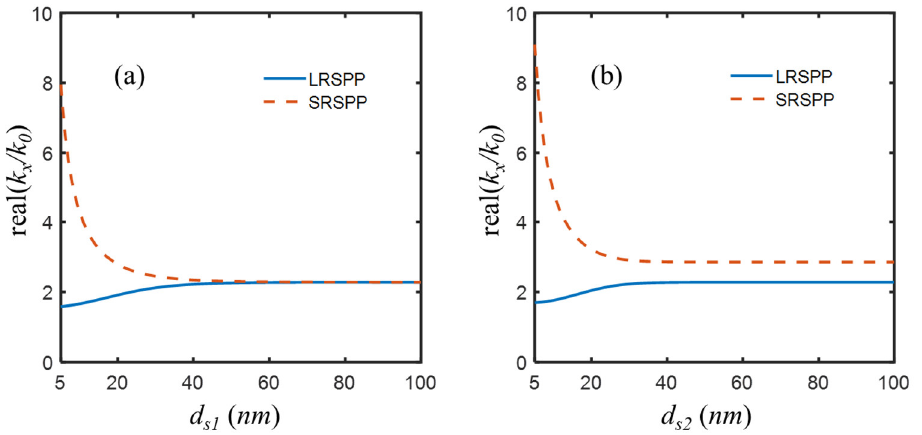
Figure 4. Real part of effective mode indices n ef f = k x / k 0 of LRSPP and SRSPP supported by totally independent ( a ) symmetric IMI with ε p = ε d = 2.4 and ( b ) asymmetric IMI with ε p = 2.4, ε q = 2.89, for Al superlens of thickness ranging from 5 nm to 100 nm, when the thickness of central dielectric d d of IMIMI is infinite.